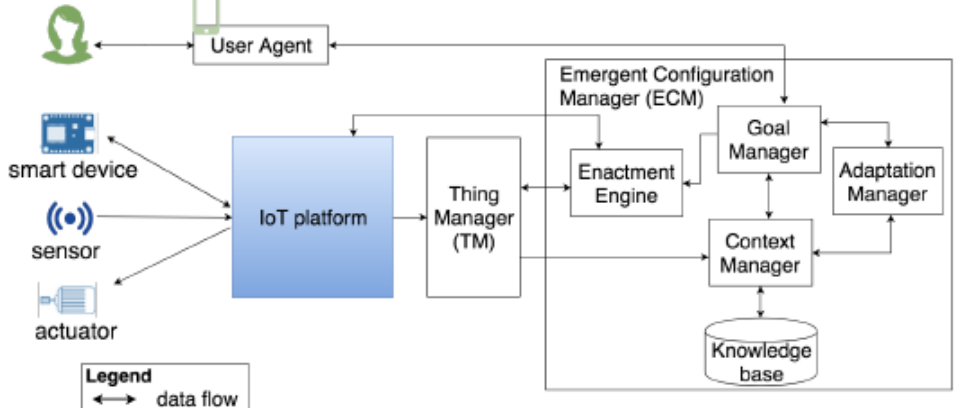
Figure 5. A refined architecture for realizing ECs